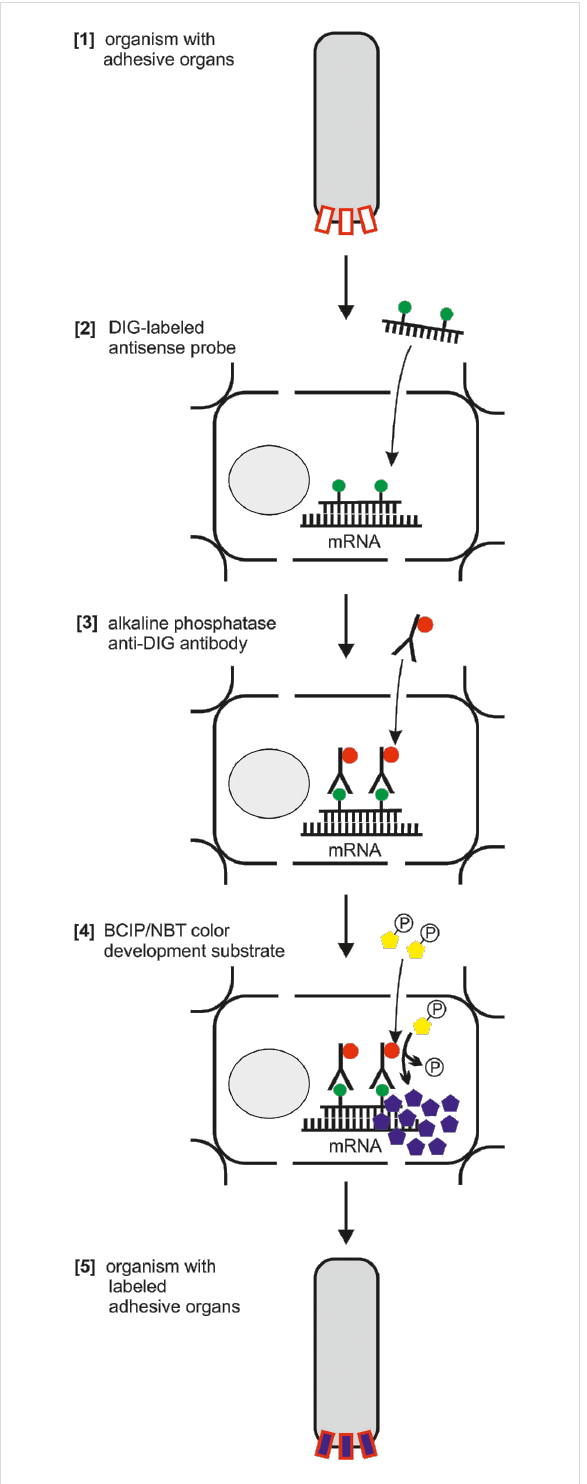
Figure 4: Principle of in situ hybridization. (1) Schematic organism with unstained adhesive organs. (2) The DIG-labelled RNA probe binds to the target mRNA and (3) is detected by an antibody conjugated with a phosphatase. (4) The former colorless substrate becomes dephospho- rylated and turns blue. (5) The staining reveals the cells with target gene expression, in this case the adhesive